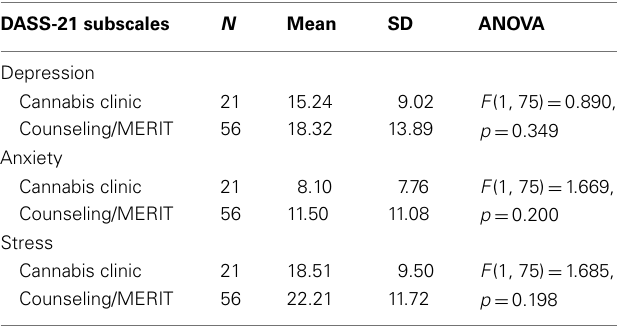
Table 7 | “Cannabis Clinic” group compared to other teams (Counseling and MERIT) # on the clinician-rated subscales of the Agnew-Davies Relationship Measure of therapeutic